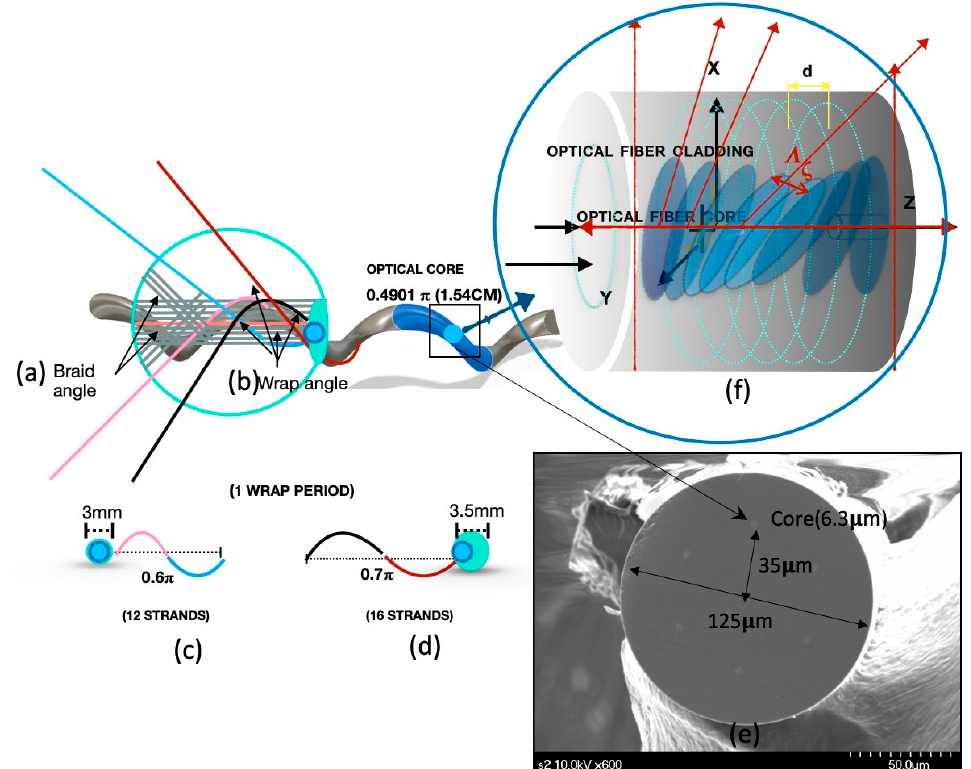
Figure 2. The correlation between the fiber Bragg grating sensor and the braiding angle and wrap angle. An example of ( a ) is the braiding angle during the braiding process and ( b ) the polyurethane wrap angle. ( c ) The wrap pitch of 0.6π and the sensor cross-section diameter of 3 mm for the 12-strand polyurethane sensor. ( d ) The 16-strand polyurethane wrap pitch of 0.7π and the sensor cross-section diameter of 3.5 mm. ( c , d ) The samples after brazing, and ( e ) electron micrograph of the braided sensor. It also shows a core position in the optical fiber with a 125 µm diameter and the Bragg grating sensor core with a 6.3 µm diameter. ( f ) The process of the stress–strain response applied to the Bragg grating sensor through the braiding process.